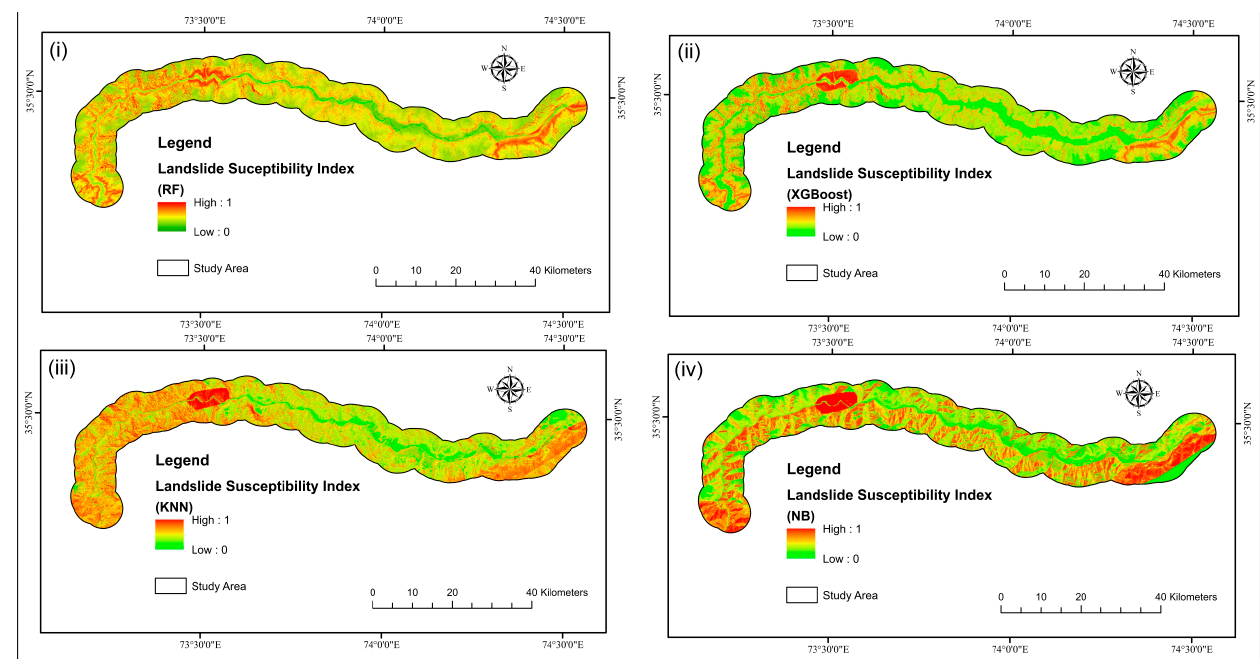
Figure 9. Landslide susceptibility index maps ( i ) RF, ( ii ) XGBoost, ( iii ) KNN, ( iv ) NB.